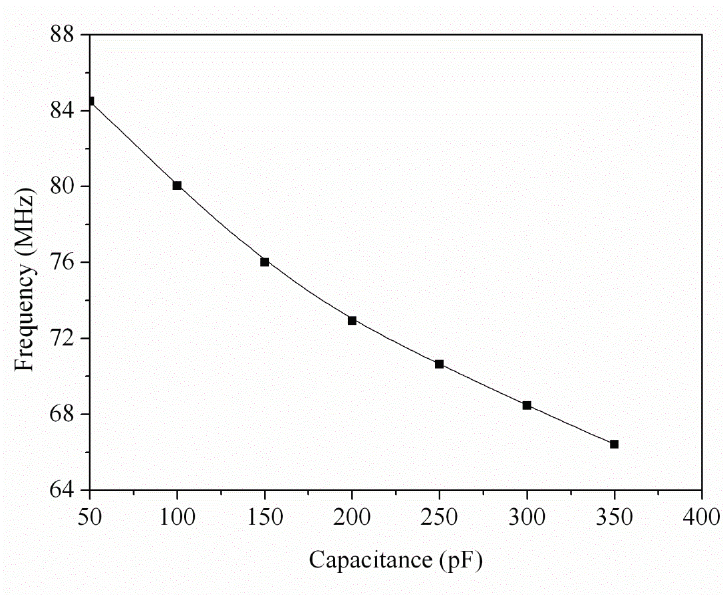
Figure 3. Simulation results of output frequency for the ring oscillator